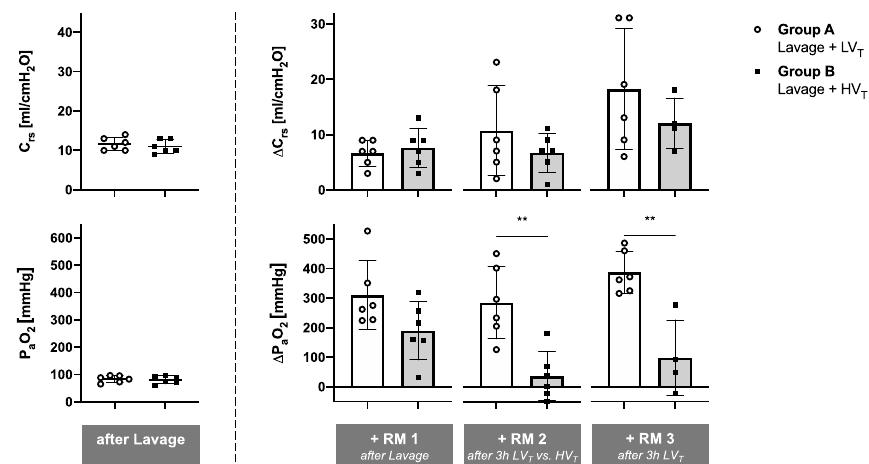
Fig. 3 Ventilation-induced deviation from lavage-induced impairment of respiratory mechanics and function. Dynamic compliance of the respiratory system ( C rs ) and arterial partial pressure of oxygenation (P a O 2 ) were assessed in anesthetized pigs after lavage-induced surfactant depletion, and after consecutive recruitment maneuvers (RM) at 3 h intervals. Figure depicts the relative deviation of C rs and P a O 2 (obtained after RM) from the respective values after initial lavage. Group A, N 6: continuous automated protective = low tidal volume ventilation (LV T ). Group B, N 6: 3 h of injurious high tidal volume ventilation (HV T ) prior = to RM 2, resumption of protective low tidal volume ventilation for 3 h prior to RM 3. Two animals died after injurious HV T and RM 2, i.e., Group B, N 4 at RM 3. For experimental protocol, see Fig. 1. Scatter/bar plots = with horizontal (means) and error bars (SD). ** p < 0.01, Mann–Whitney U